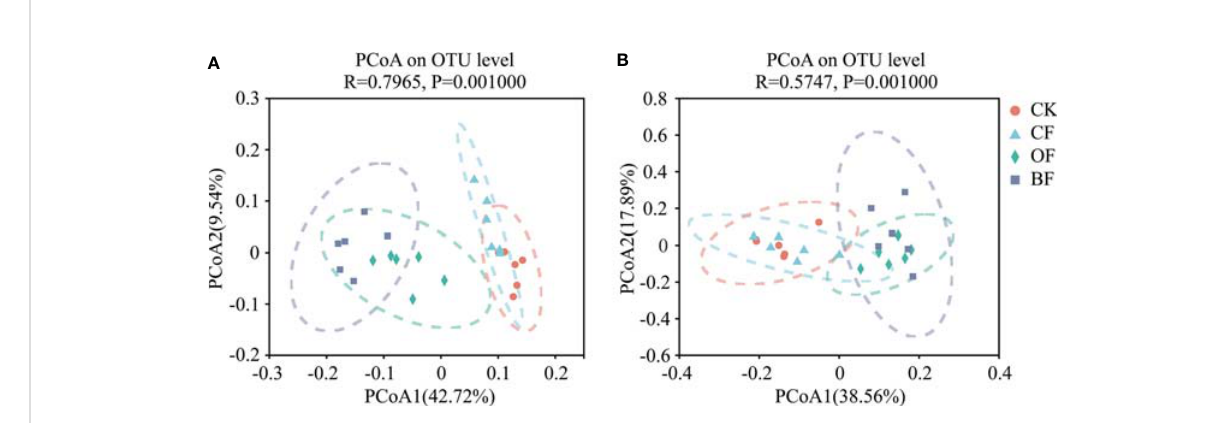
FIGURE 2 Comparison of the bacterial (A) and fungal (B) communities in soils under the different fertilizer treatments based on a principal coordinates analysis of Bray-Curtis distances. CK is untreated control; CF is chemical fertilizer; OF is organic fertilizer; BF is bioorganic